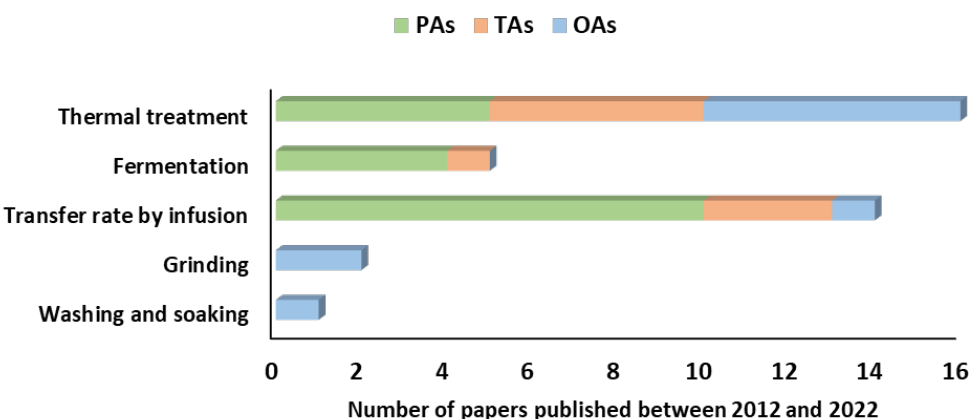
Figure 3. Overview of the number of works currently available in the literature addressing the effect of different food processing and culinary preparations on the content of pyrrolizidine (PAs), tropane (TAs) and opium (OAs) alkaloids. Data obtained from the Scopus, Web of Science and Google search engines from January 2012 to December 2022 (keywords used: transfer rate, food processing, alkaloids degradation, plant toxins, pyrrolizidine alkaloids, tropane alkaloids, opium alkaloids, culinary process, alkaloids stability).